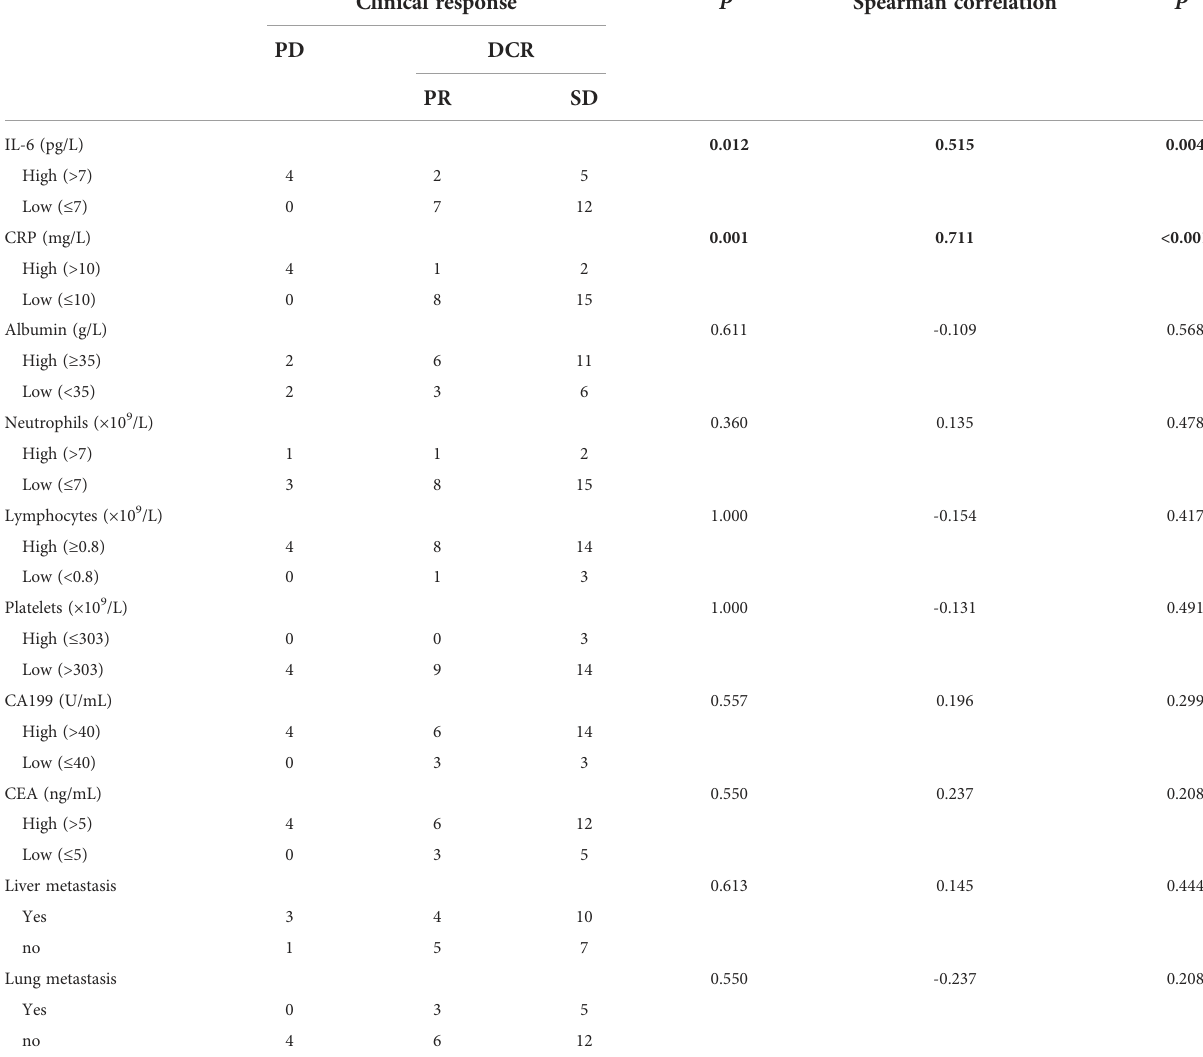
TABLE 3 Correlation between clinicopathological markers and clinical response in patients with mPC treated with mFOLFIRINOX. Clinical